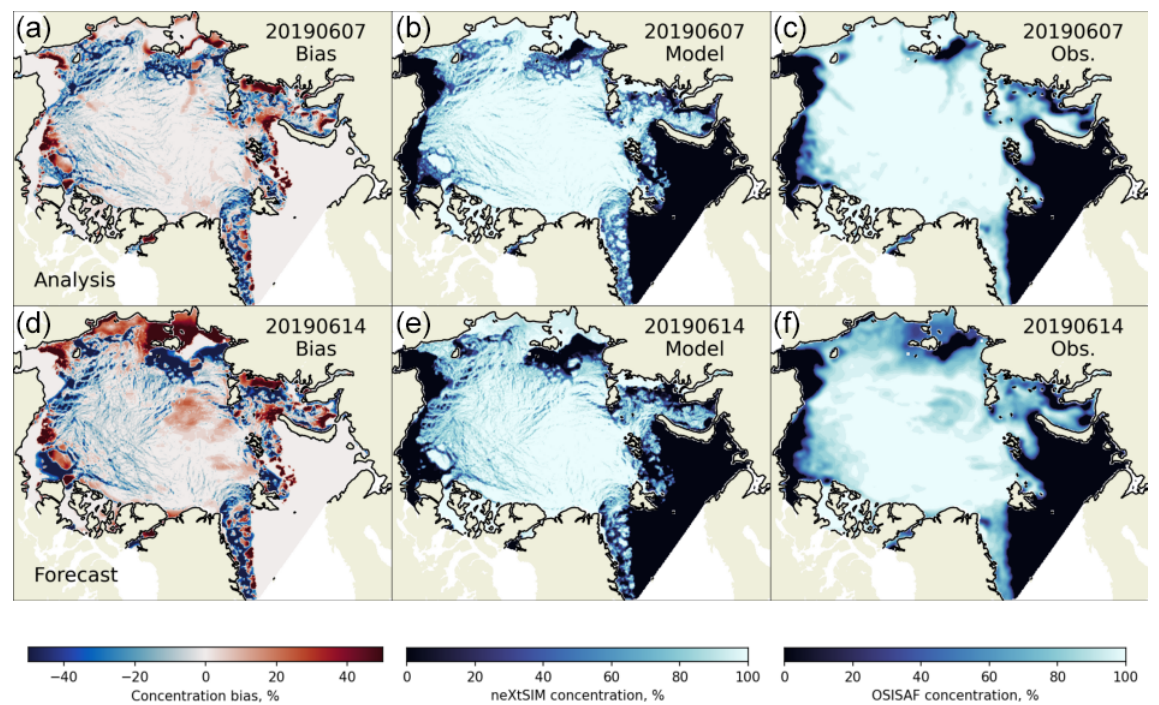
Figure 11. Maps of daily-averaged biases (a, d) in concentration compared to OSI SAF SSMIS, and modelled (b, e) and observed (c, f) concentrations, for an example forecast starting on 6 June 2019. Panels (a) – (c) show the comparison for the first day of simulation, while panels (d) – (f) show the comparison for the eighth day of simulation. The bias is defined as model minus observation.